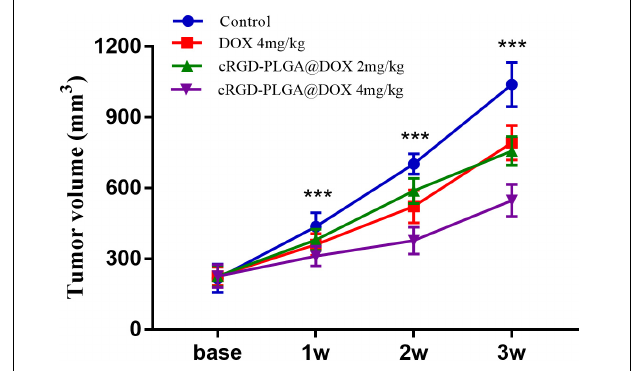
FIGURE 2 | The tumor growth within 3 weeks in Group A, B, C and D. Eight rats were measured and averaged in each group. Group D demonstrated the smallest tumor volume and the highest tumor inhibition rate in 3 weeks, followed by Group C, B, and A. *** P < 0.001.